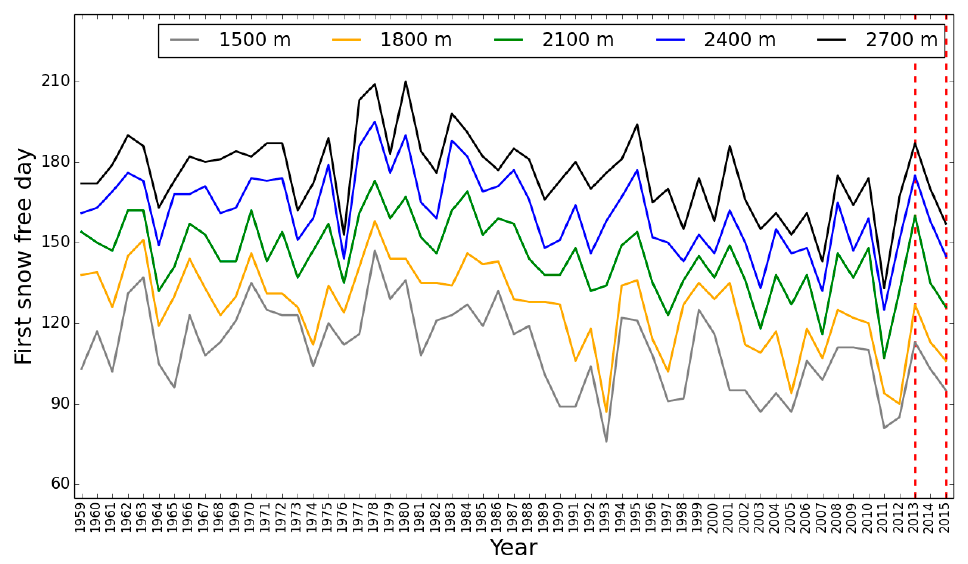
Figure 4. The first snow free day (in Julian Day) for different elevations in the Oisans mountain range from SAFRAN-SURFEX/Crocus-MEPRA model chain (S2M). Vertical dashed red lines indicate the years considered in our study (2013 and 2015).